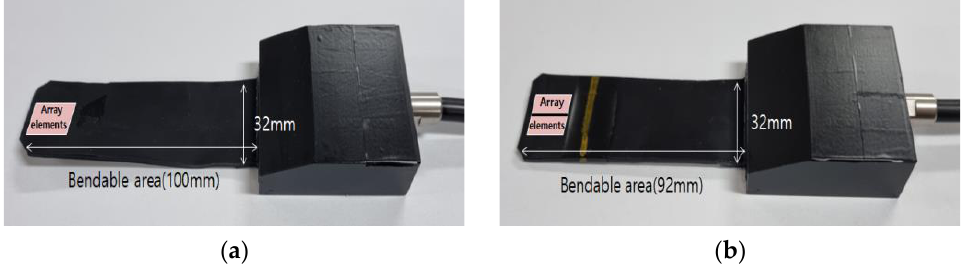
Figure 10. Images of phased array probe excluding solid wedge; ( a ) a photo of an FPAPr manufac- tured in P/E type; ( b ) a photo of an FPAPr manufactured in T/R type.